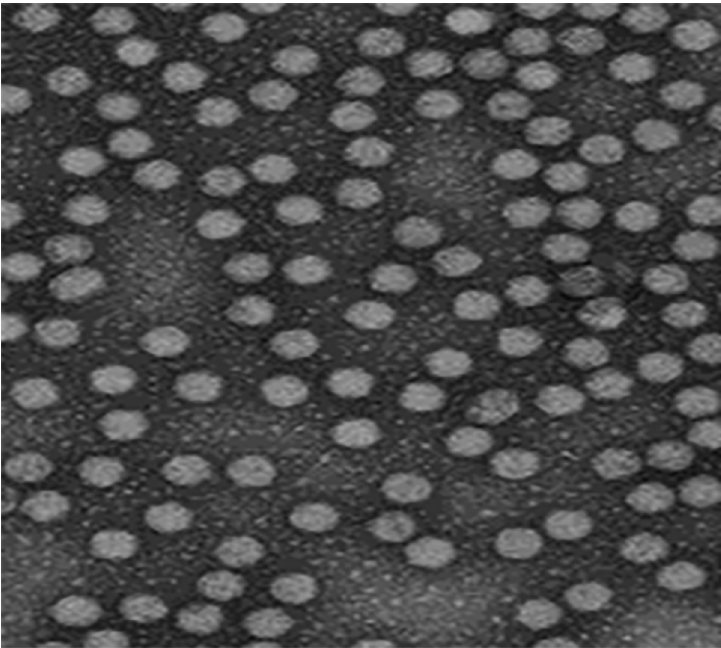
Fig 3. Transmission electron microscopy IBDV after negative staining with 2% sodium phosphotungstate.